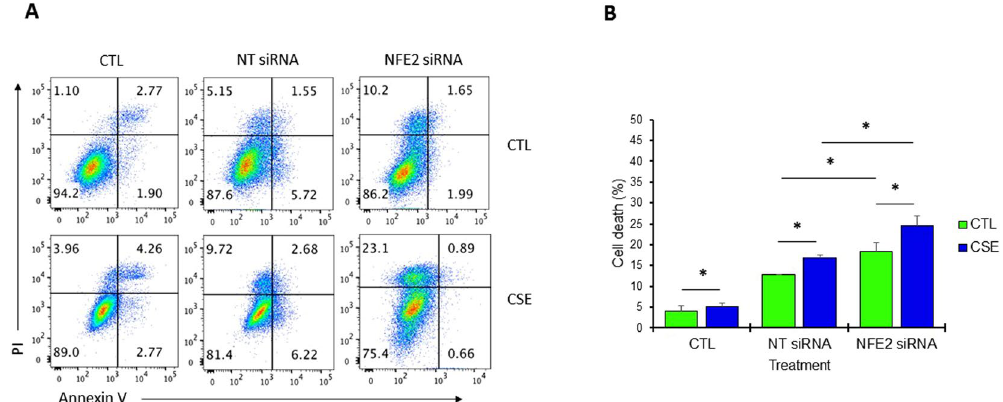
Figure 3. NFE2 knockdown increases cell death induced by CSE in A549 cells in vitro . ( A ) A549 cells were transfected with 100 nM NFE2 siRNA or non-targeting (NT) siRNA followed by exposure to CSE for 24 h. Representative flow cytometry images using Annexin V and PI staining are shown. ( B ) NFE2 knockdown significantly increased cell death after treatment with CSE compared to control. * Statistically significant difference ( p < 0.05). Data are shown as the mean ( ±